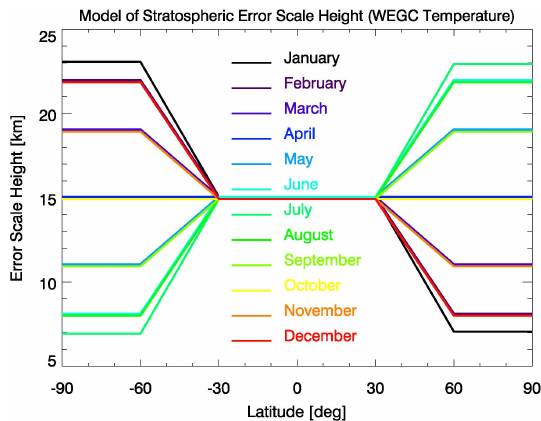
Fig. 6. Temperature stratospheric error scale height as a function of latitude for different months (different colors) as modeled by Eq.